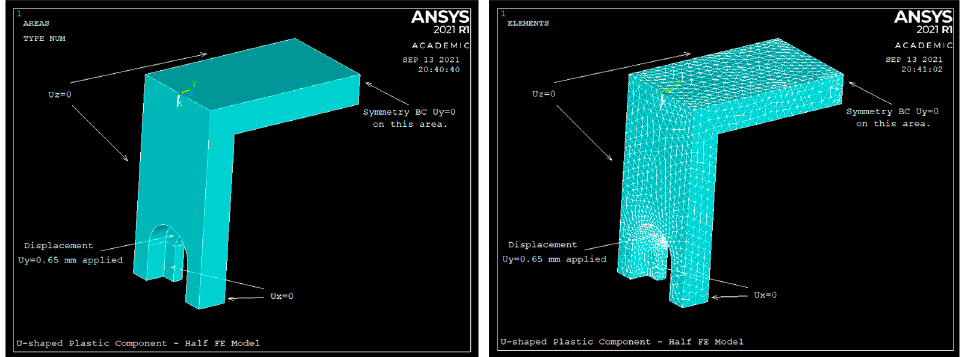
Figure 12. Half ANSYS FE model and its boundary conditions.